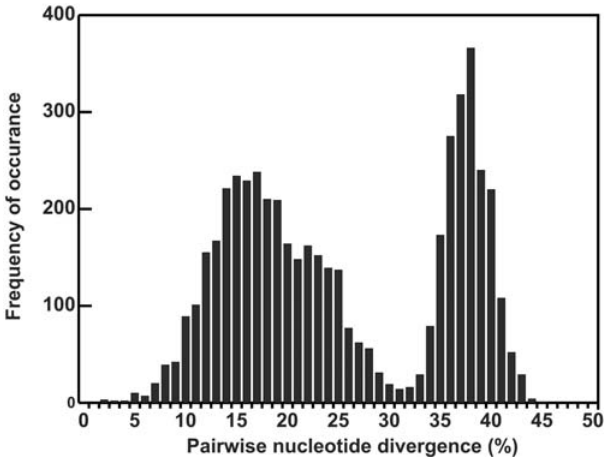
Figure 2. Distribution of pairwise nucleotide divergence values between 101 HRV serotypes. The horizontal axis shows the value of divergence (%) in pairwise comparisons and the column height indicates the frequency of observations. Divergence values were calculated as distance value 6 100%.